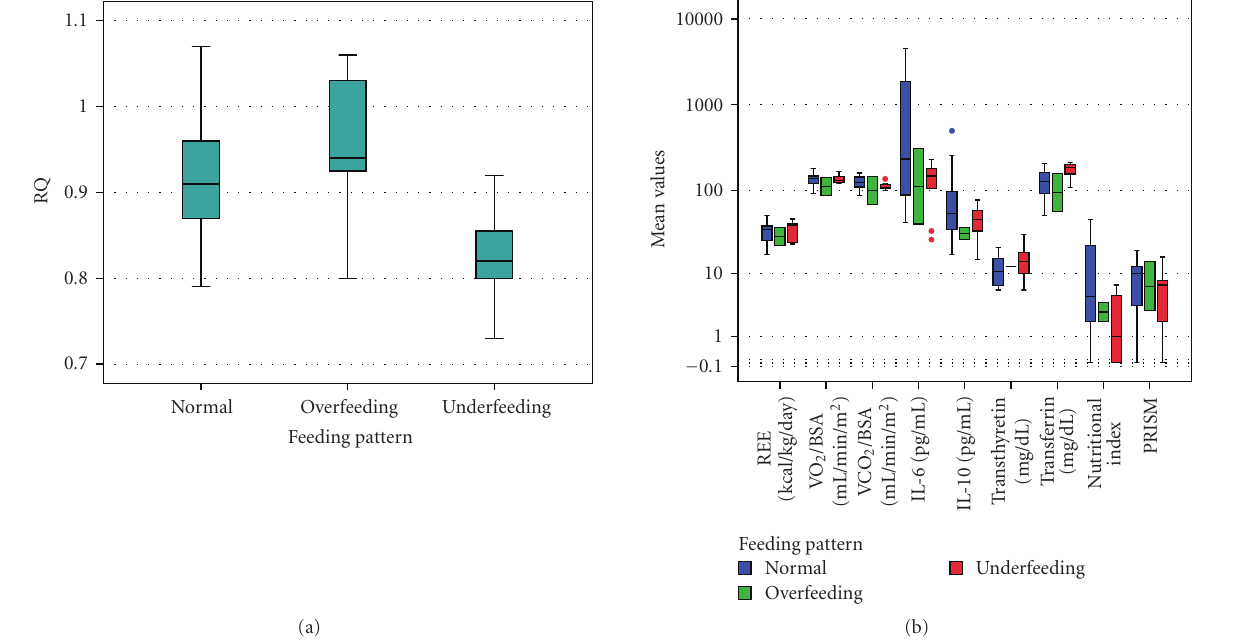
Figure 8: (a) Only the respiratory quotient (RQ) varied at higher levels in the overfeeding compared to the other groups (ANOVA, Bonferroni post-hoc tests, P < . 0001); (b ) Nutritional and stress indices did not di ff er among feeding groups during the acute phase of stress. The Box-whisker plots show the median (horizontal line within the box), and the 10th and 90th percentiles (whiskers). The box length is the interquartile range (logarithmic scale). Solid circles represent outliers. REE: Resting Energy Expenditure, VO 2 : Oxygen Consumption, VCO 2 : Carbon Dioxide production, BSA: Body Surface Area, IL-6: Interleukin-6, IL-10: